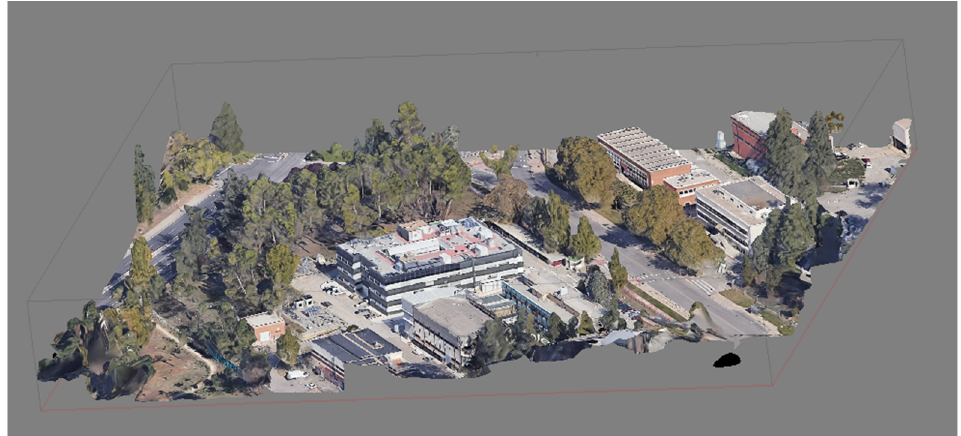
Figure 2. 3D model of the urban environment in Ciemat campus Madrid from photogrammetry process.